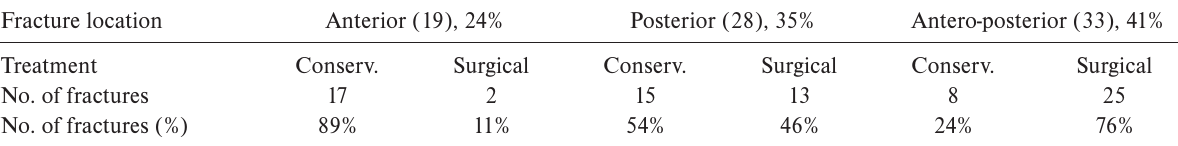
Table 4. The frequency of blow-out fractures by location and the relationship between conservative and surgical therapy.